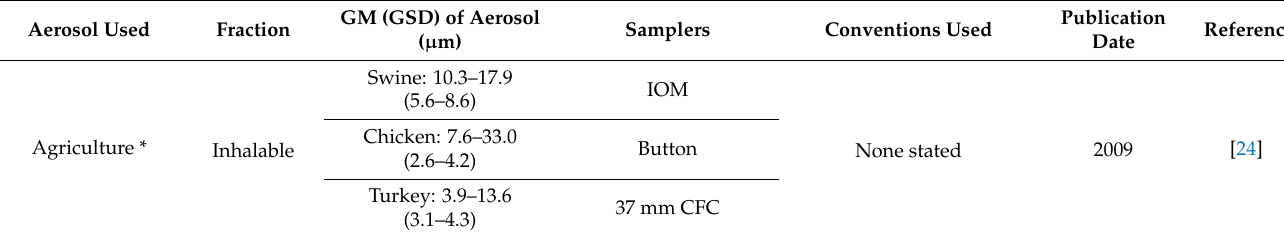
Table 2. Aerosols and conventions used in the included